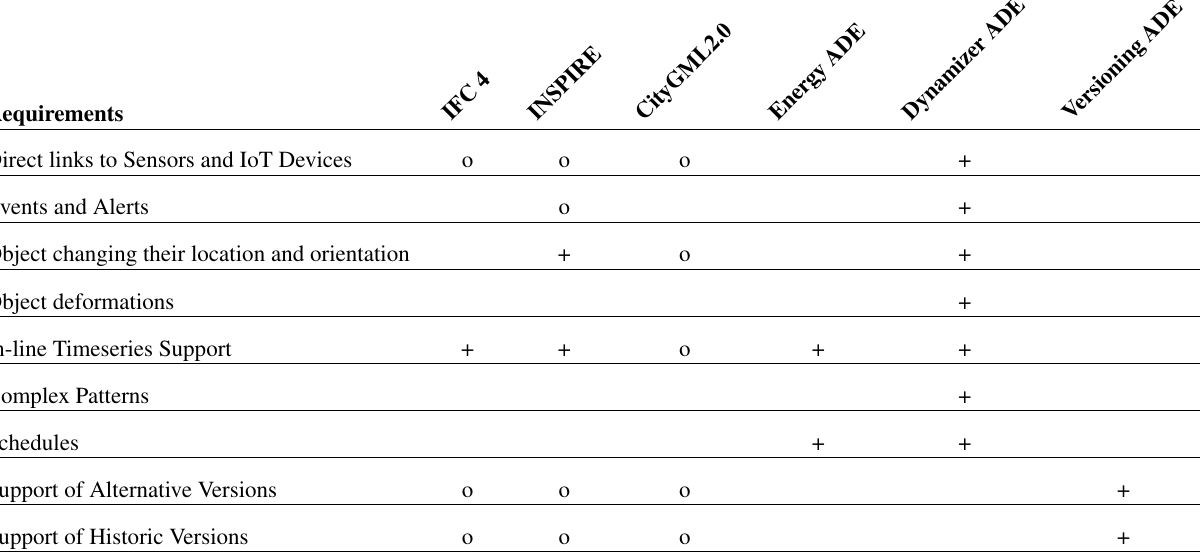
Table 2. Evaluation of Semantic 3D City Model standards for the listed requirements. ’+’ denotes complete support and ’o’ denotes limited support of the requirement by the standard specification or the related extension. in-line timeseries as well as by linking with external